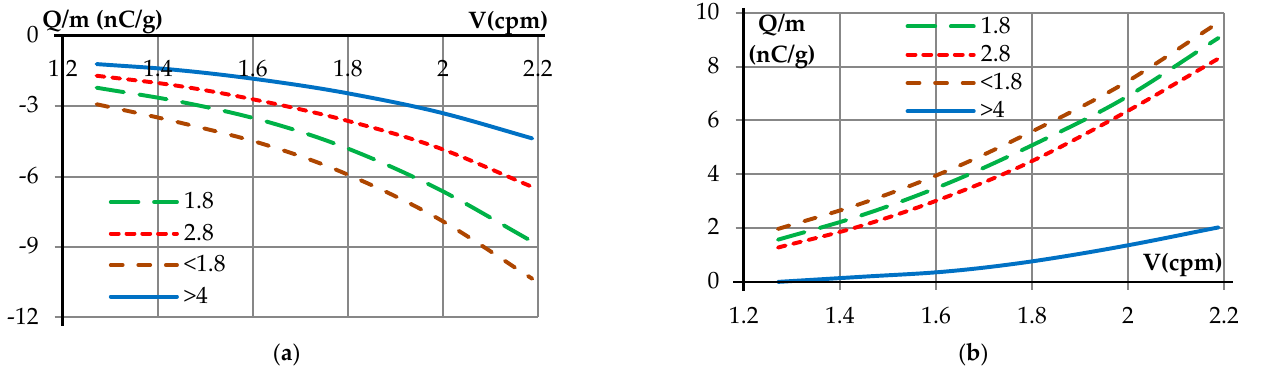
Figure 12. Charge density per mass as a function of airflow for tribocharging process of ( a ) PET in the container made of PP; ( b ) PE-HD in the container made of PET-G for a constant time of the charging process t = 30 s for fraction mass 10 g.